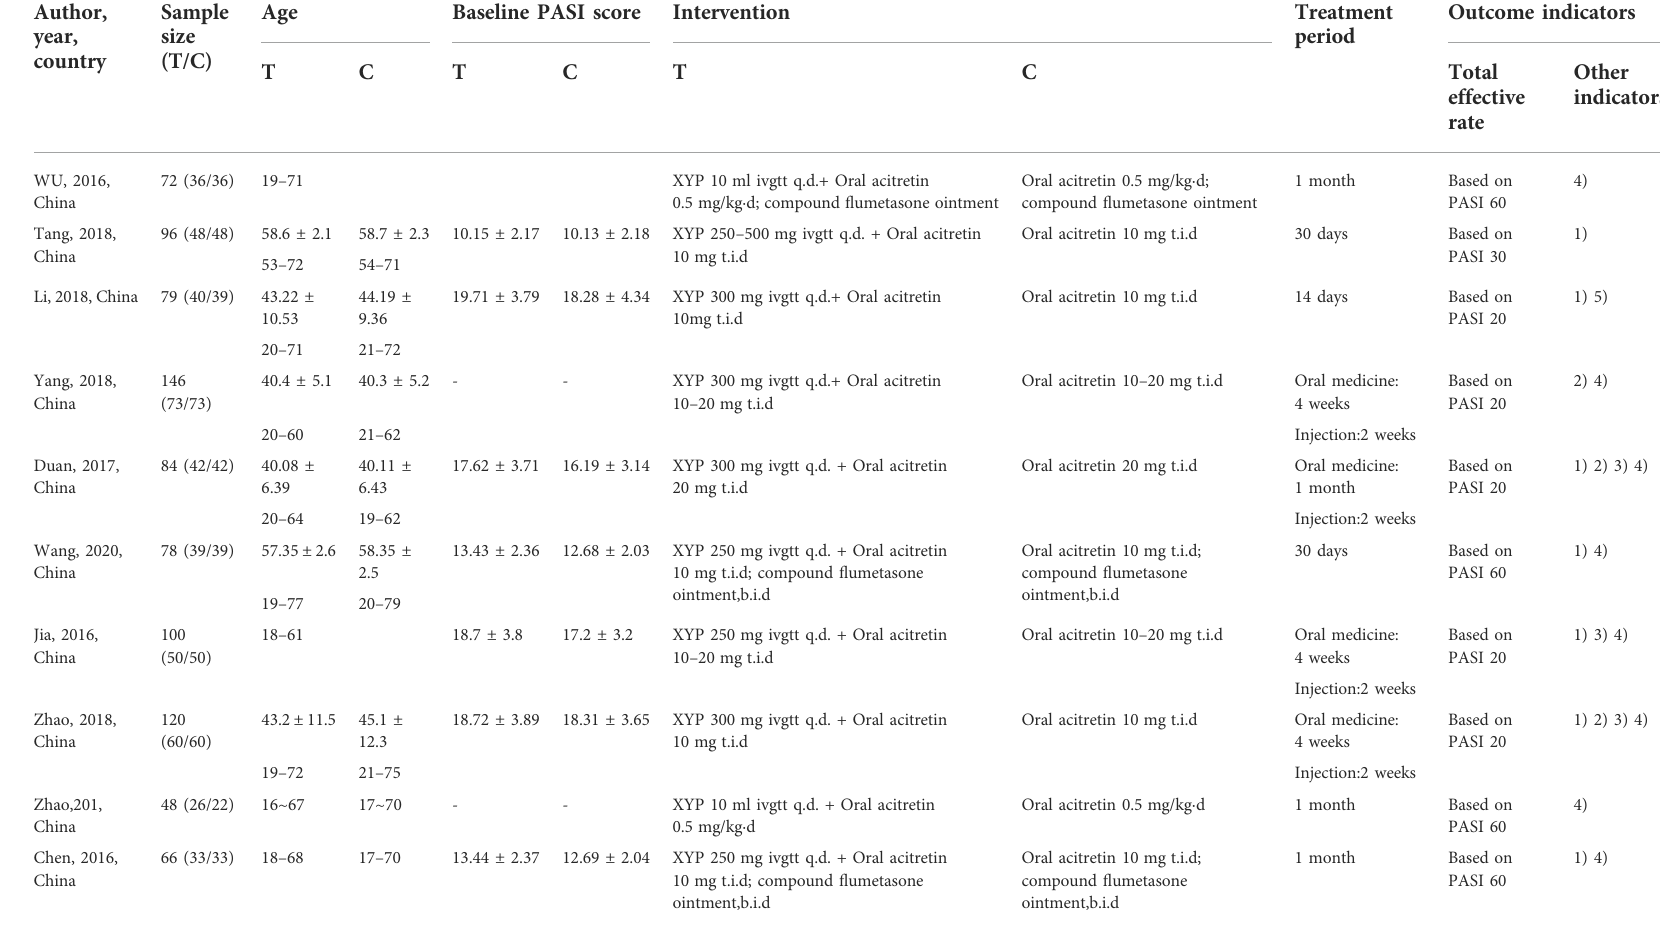
TABLE 1 Characterization of selected